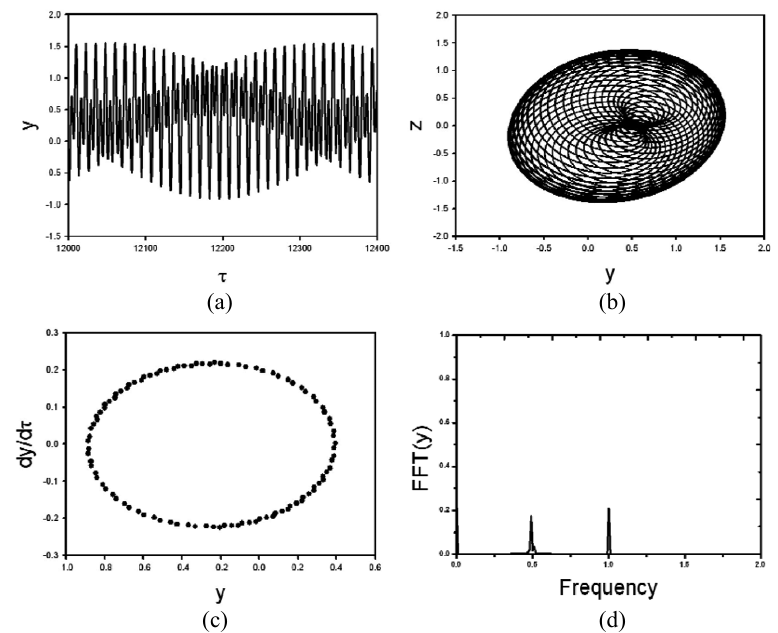
Fig. 12. Dynamic characteristic of the y-displacement of the mid-span point with ω = 700 rad/s. (a) Time history; (b) Orbital trajectory; (c) Poincar´e section; (d)